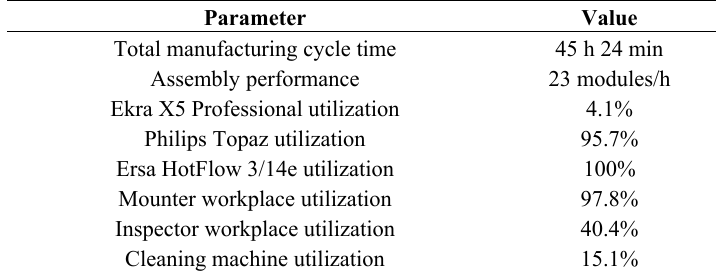
Fig. 9 . The improved simulation model of the assembly line using three workplaces of installers instead of one and the corresponding simulation results: (a) layout of the improved simulation model; (b) statistics of the component pick-and-place machine Philips Topaz; (c) statistics of the reflow oven Ersa HotFlow 3 / 14e. Table 2. Summary operation statistics of the assembly line with three mounter